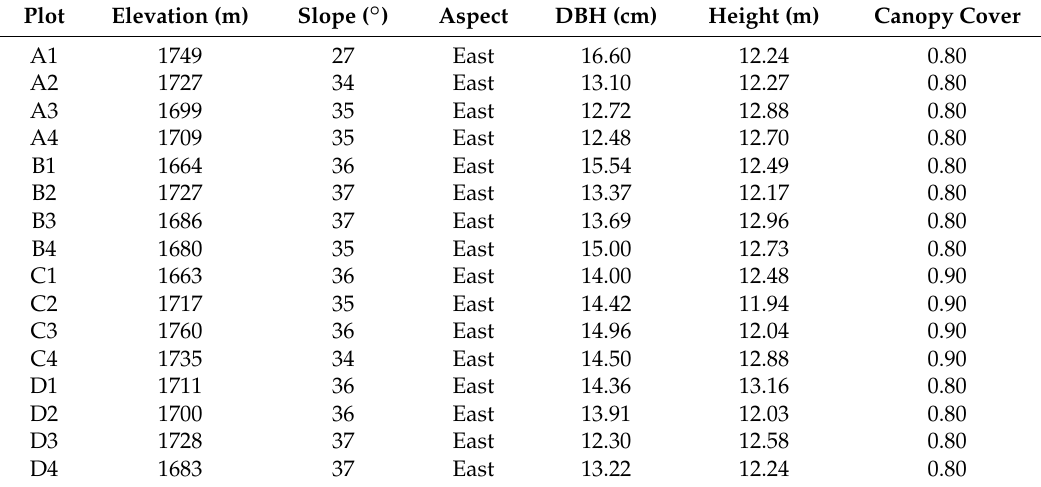
Table 1. Basic characteristics of